Question: Describe this figure in one sentence.
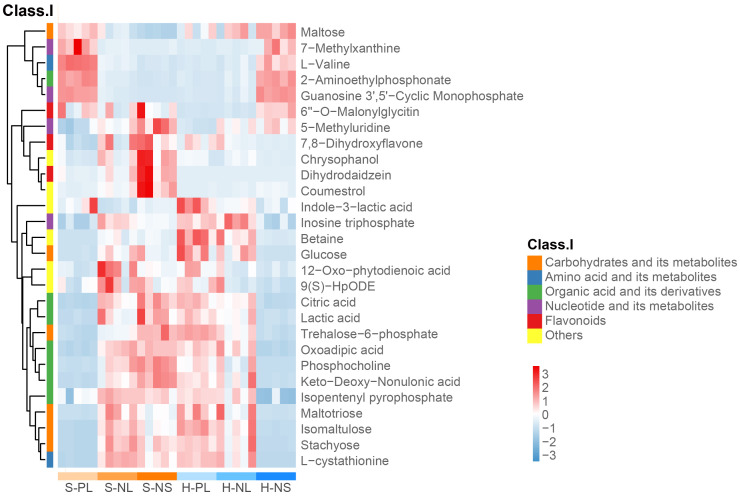
Answer: Clustered heatmap of differential metabolites under S3 salt treatment. S, Soybean; H, Suaeda salsa . PL, Plastic barrier separation; NL, Nylon mesh separation; NS, No separation.